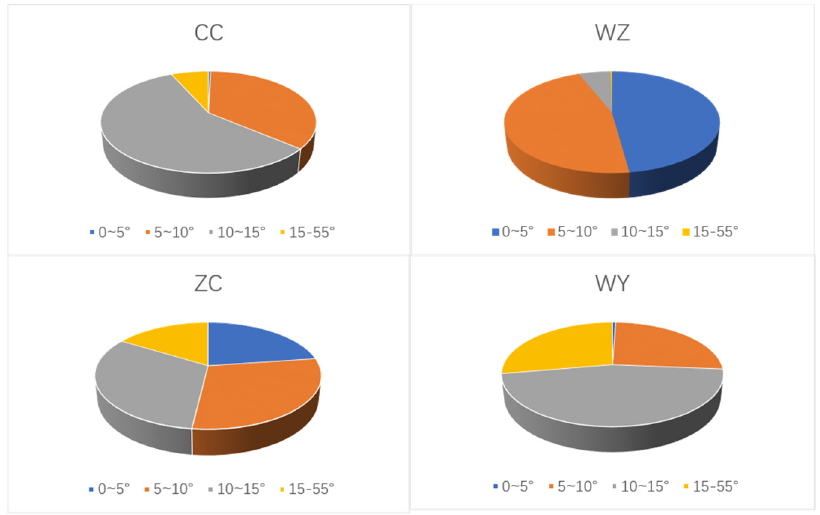
Figure 4. Temperature pie chart of gangue piles.